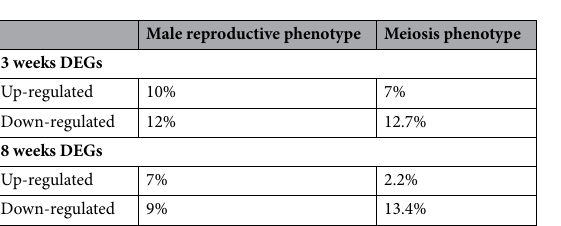
Figure 3. Cell type enrichment (CTen) analysis of the up-regulated and down-regulated genes. A minimum score of 2 is required to obtain confident cell type enrichment. In both age groups, the down-regulated genes point to testicular cells and the up-regulated genes point to a variety of somatic cell types like osteoblast, mammary gland, uterus, placenta, lung, bladder, dorsal root ganglia and others. B-cells GL7 neg./pos. Alum/ KLH (with and without adjuvants Alum and KLH), Macrophages peri LPS 1 h and 7 h (1 and 7 hrsLPS challenged perinoteal macrophages).